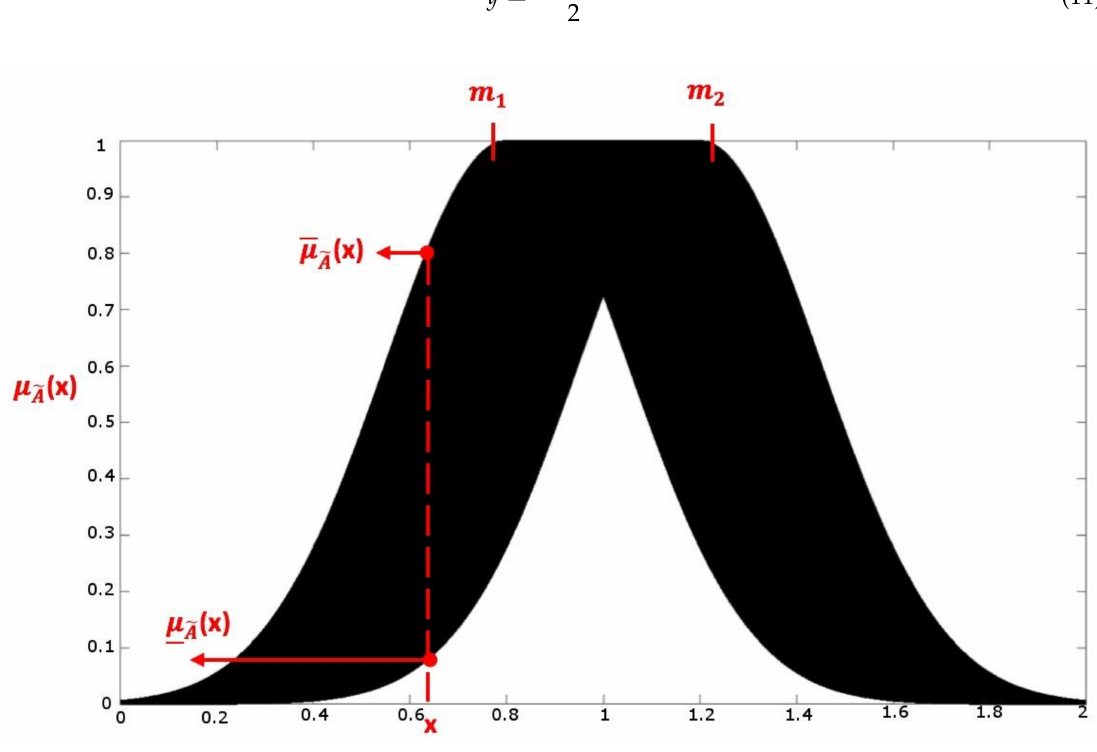
Figure 2. Interval type-2 fuzzy